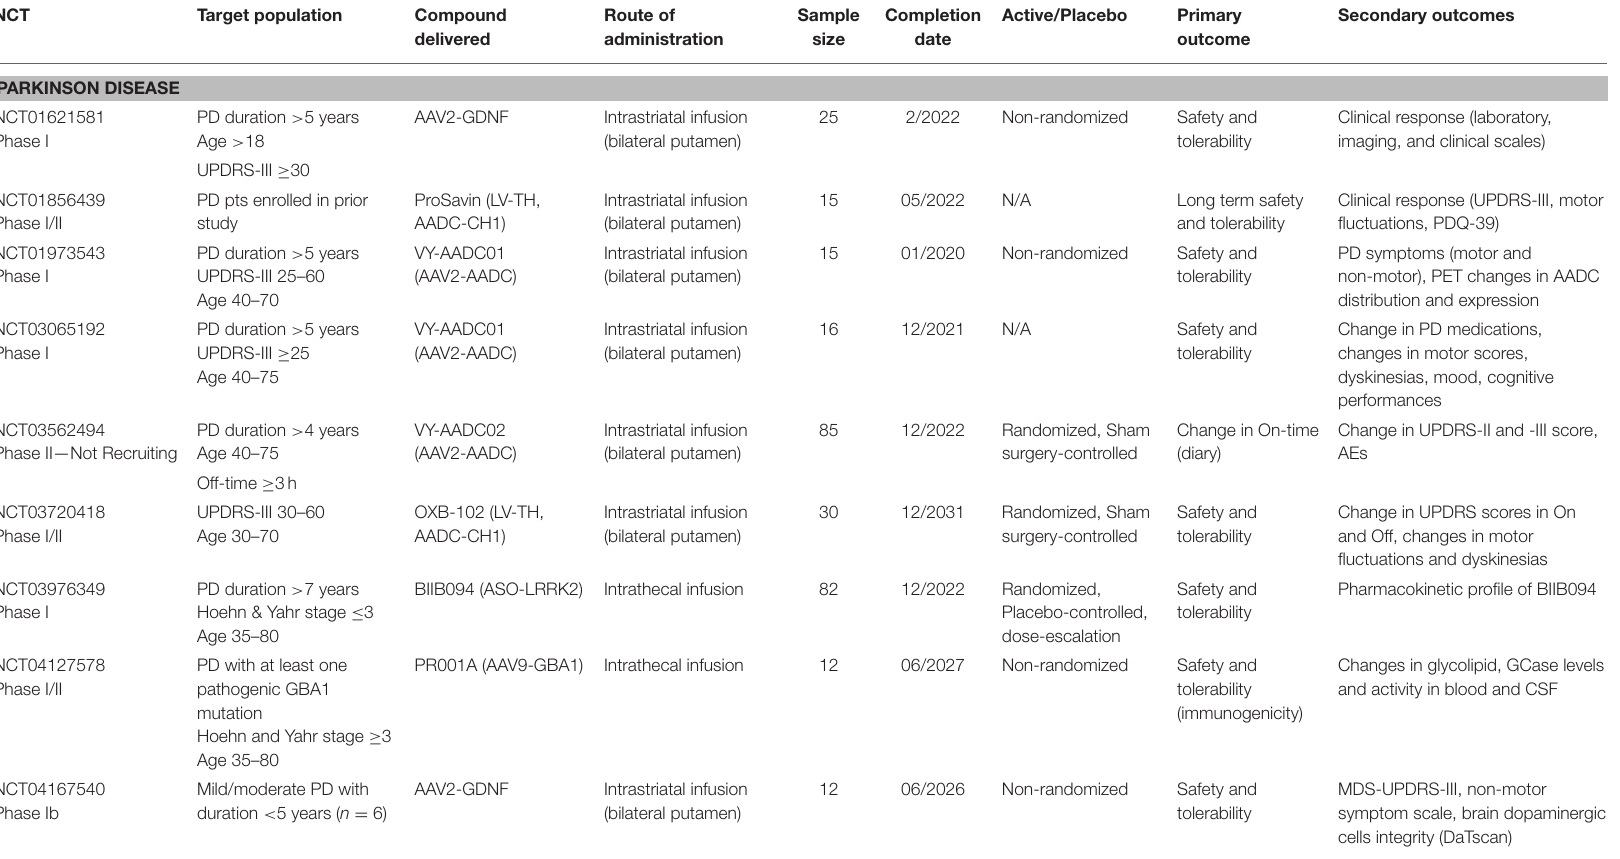
TABLE 7 | Ongoing